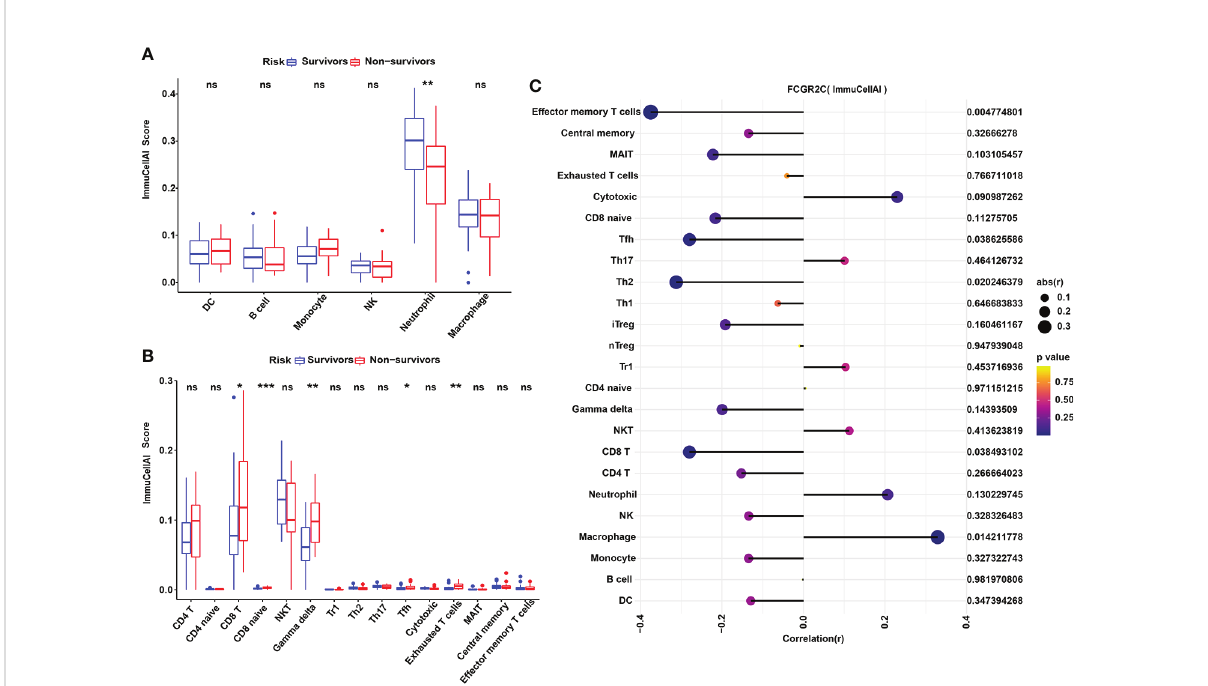
FIGURE 6 Immune cell analysis with ImmuCellAI in the discovery cohort. (A) The ImmuCellAI algorithm was used to analyze the immune cells other than T cells between septic survivors and non-survivors. (B) The ImmuCellAI algorithm was used to compare T-cell subsets between septic survivors and non-survivors. (C) Correlation analysis of FCGR2C with immune cells. Dots indicate the intensity of the correlation, and different colors indicate the P-value. (*P< 0.05, **P< 0.01, ***P < 0.001, ns:no signi fi